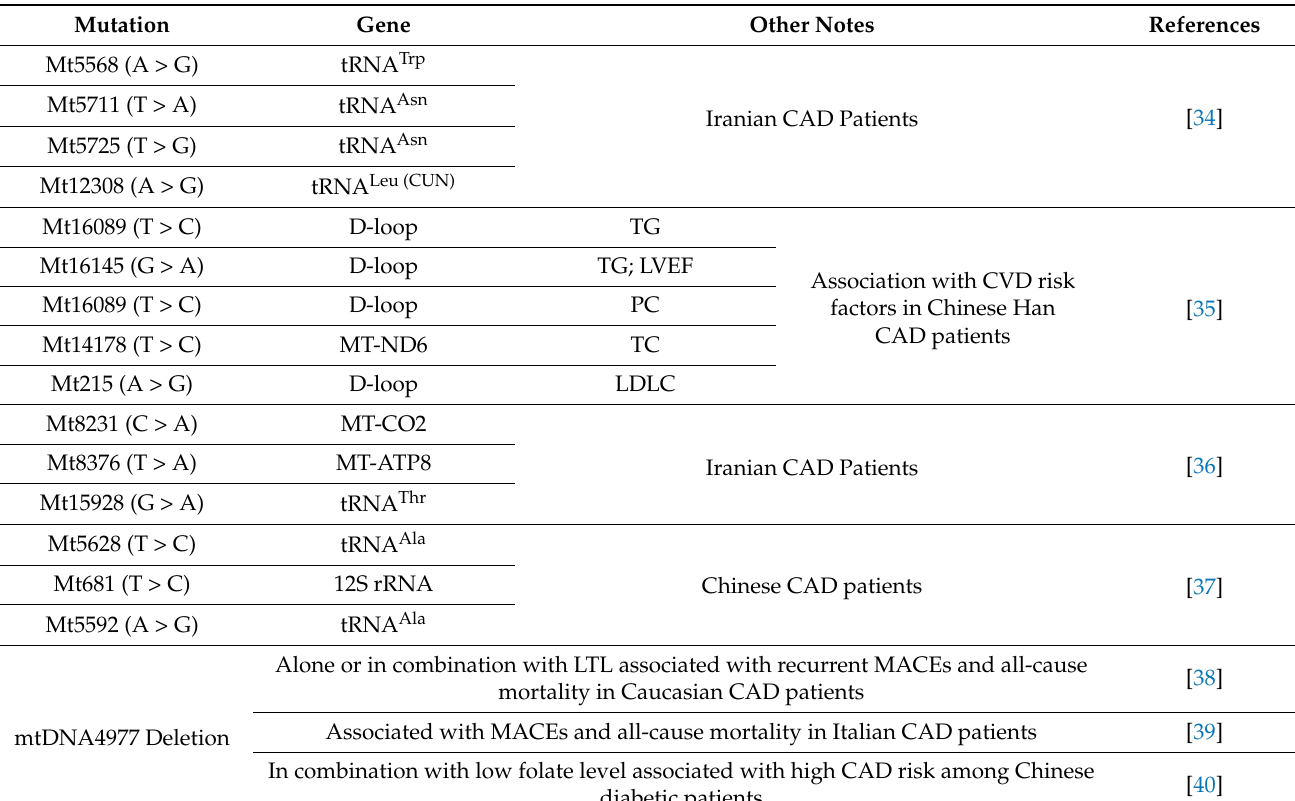
Table 1. List of mtDNA mutations associated with